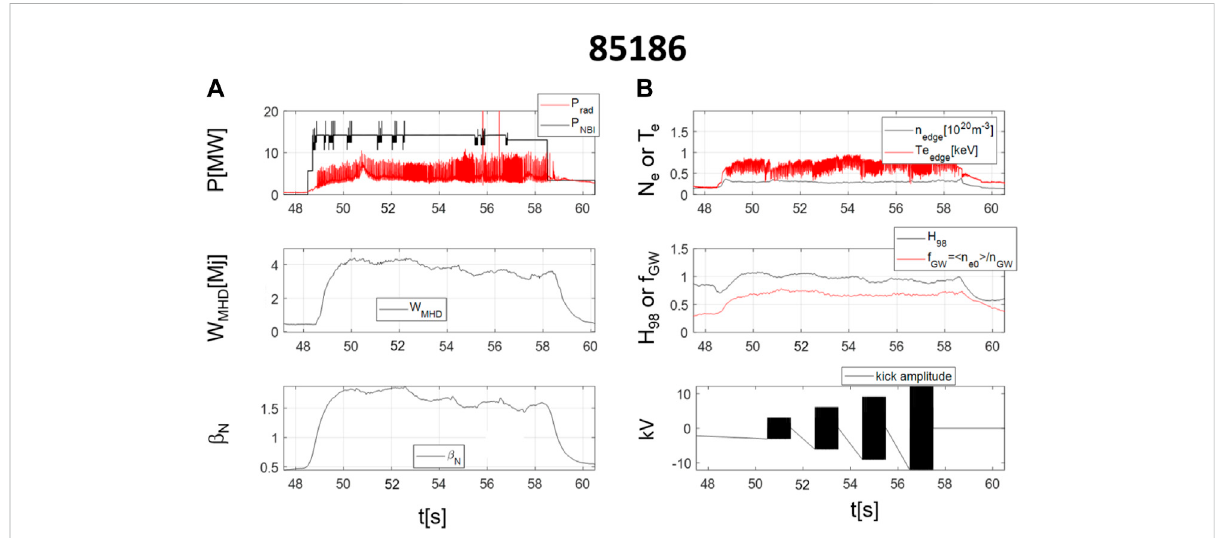
FIGURE 5 Main plasma parameters of discharge 85,186. From top to bottom (A) additional heating powers, plasma internal energy, normalised plasma beta. From top to bottom (B) central electron temperature and density, global improved con fi nement factor and Greenwald density fraction. The vertical black rectangles in the bottom left plot indicate the interval of the kicks, in increasing order of amplitude. The triggering ef fi ciency was estimated in [34] to be low, about 40%, in the fi rst interval and almost 100% in the following three